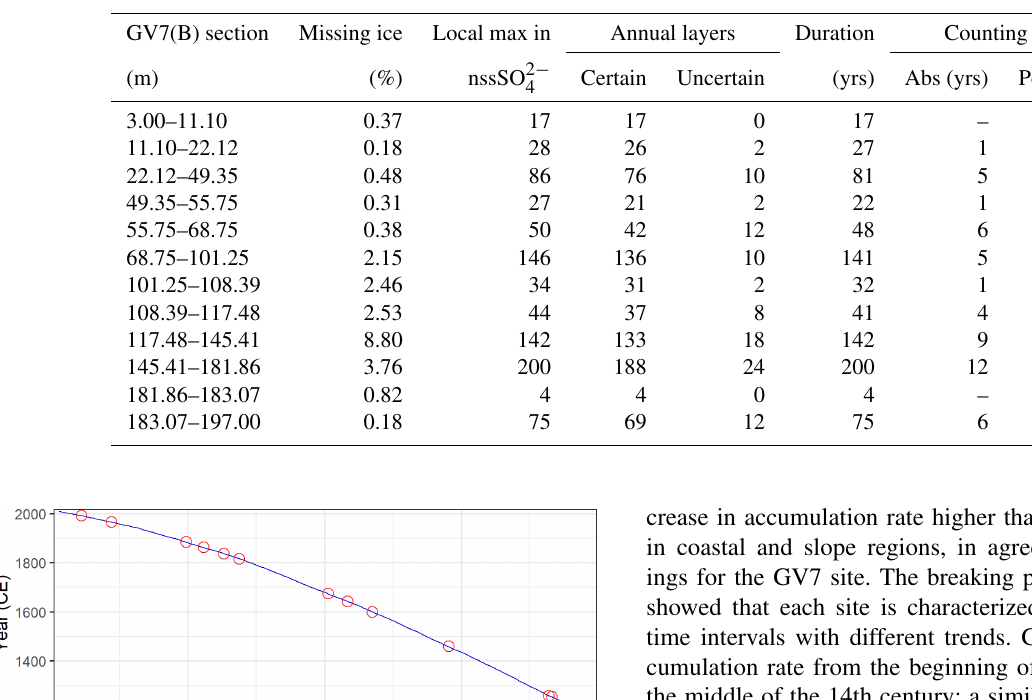
Table 2. Uncertainty of the GV7(B) ice core dating in the depth intervals comprised between two consecutive volcanic eruptions. Missing sections of the core, as percentages, are also reported.